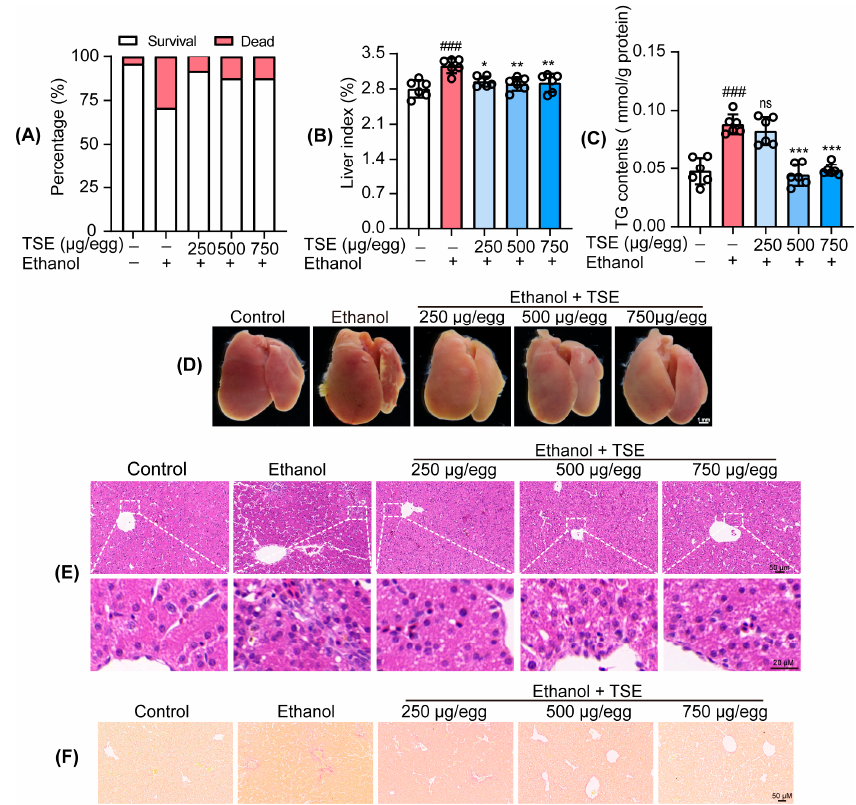
Figure 4. TSE ameliorated ethanol-induced chicken embryo death and liver damage. ( A ) TSE reversed ethanol-induced chick embryo death rates and ( B ) liver index, n = 6 biologically independent samples. ( C ) The effect of TSE on ethanol-induced changes of TG level in chicken embryo liver, n = 6 biologically independent samples. ( D ) Representative images of chicken embryo liver; scale bar, 1 mm. ( E ) H&E staining showing the histopathological changes of livers; scale bar, 50 µ m (up), 20 µ m (bottom). ( F ) Sirius red staining showing liver fibrosis; scale bar, 50 µ m. Data represent the mean ± standard deviation and significant differences were analyzed by one-way ANOVA. ### p < 0.001 vs. control group; * p < 0.05, ** p < 0.01, *** p < 0.001 vs. ethanol group; ns, not significant vs. ethanol